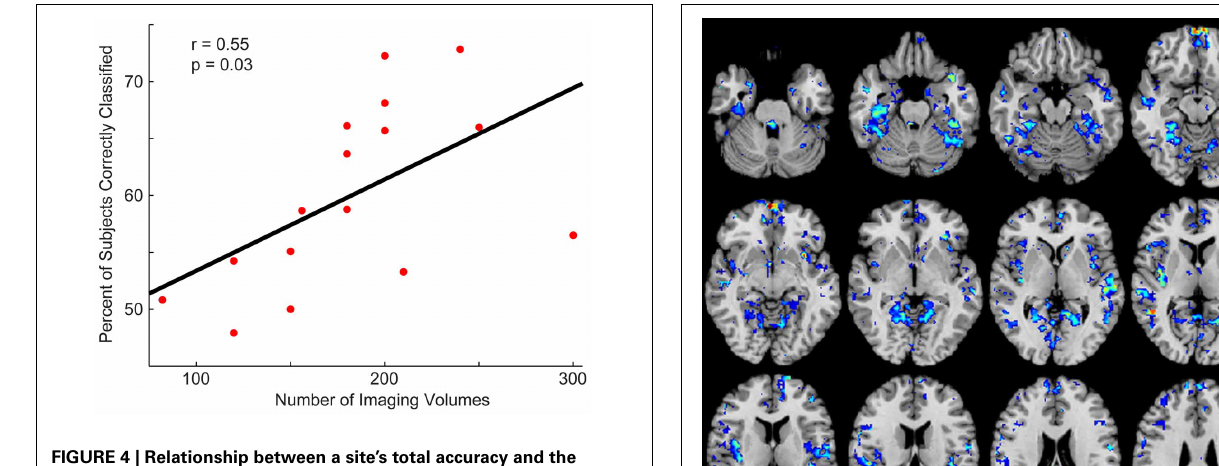
FIGURE 4 | Relationship between a site’s total accuracy and the number of imaging volumes acquired by each site. Each site’s total accuracy was calculated when using a p < 0 . 0001 threshold (i.e., the threshold at which optimal total accuracy was obtained in Figure 2 ) and correlated with the number of BOLD imaging volumes acquired during the resting-state sequence.